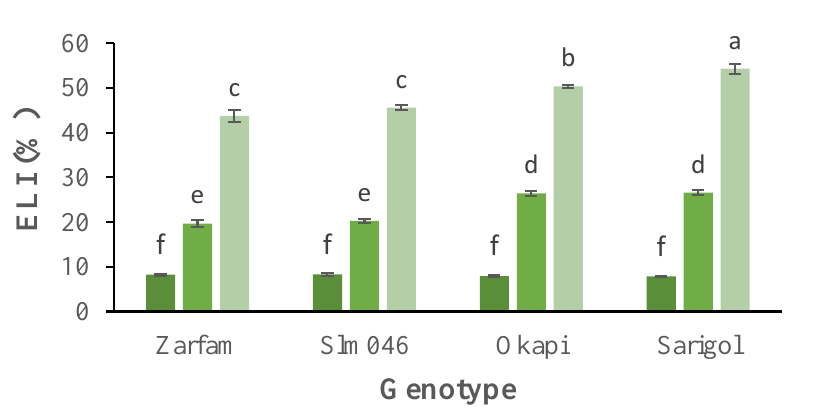
Figure 4. Interaction effect of drought stress and genotype on the electrolyte leakage index (ELI) of canola leaves. Data are means ( n = 3) ± SE. Different letters indicate differences ( p < 0.05) among treatments according to the Duncan test.